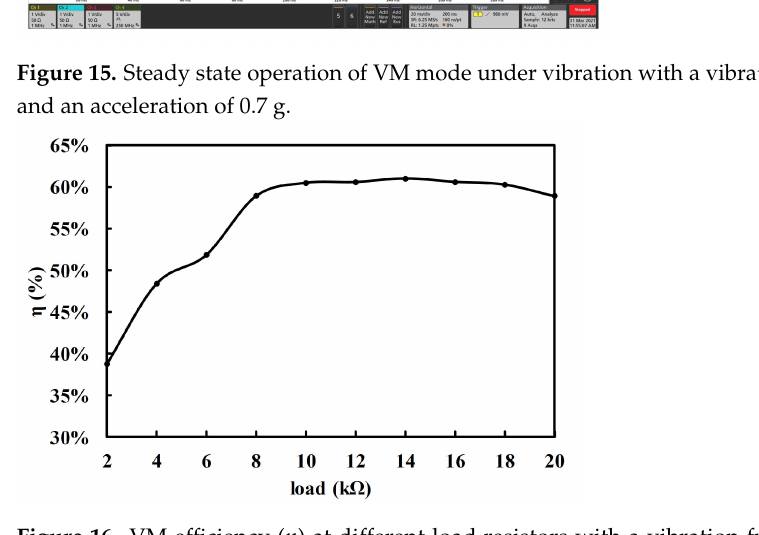
Figure 16. VM efficiency ( η ) at different load resistors with a vibration frequency of 100 Hz and V p = 1.8